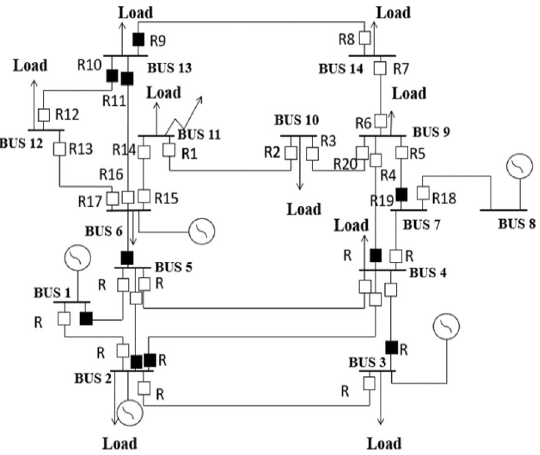
Fig. 5 IEEE 14-bus system with MBPS and fault location